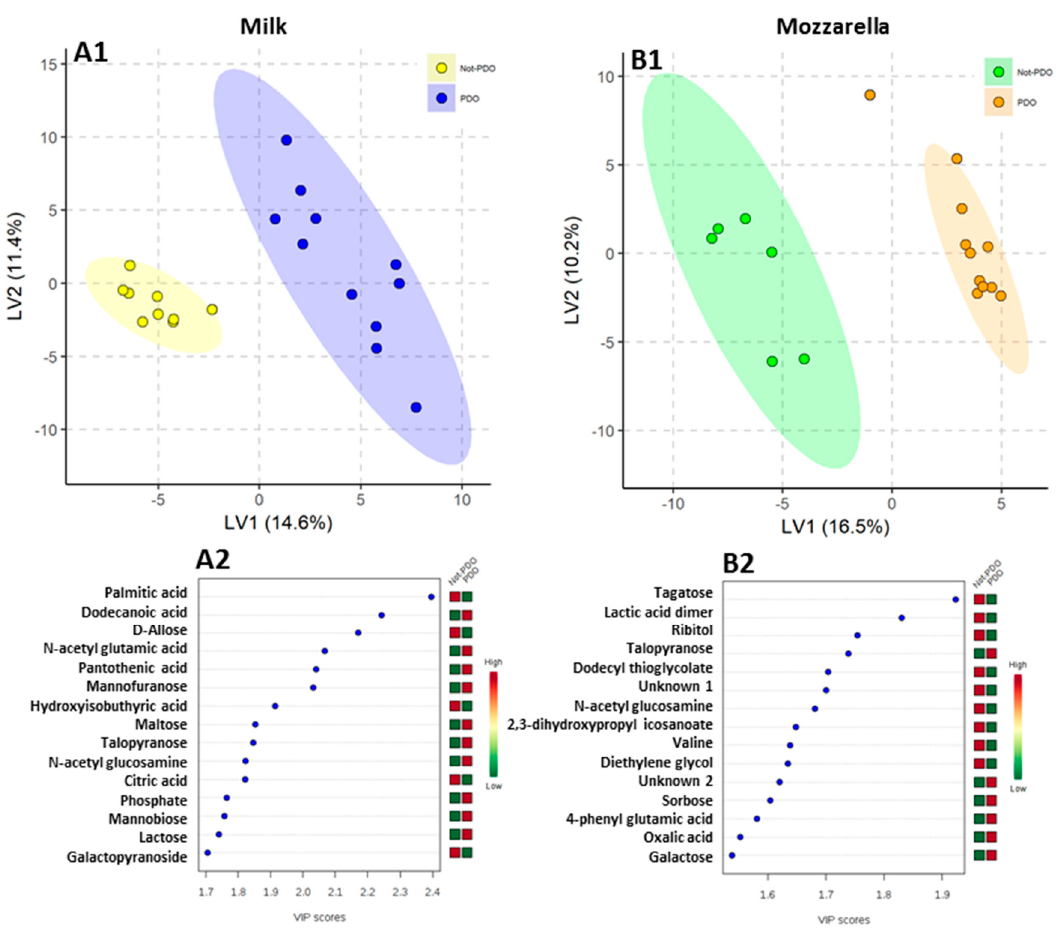
Figure 1. Partial least square discriminant analysis (PLS-DA) models to discriminate PDO and non-PDO buffalo milk ( A1 ) and mozzarella ( B1 ) samples. The explained variance of each component is shown in parentheses on the corresponding axis. ( A2 ) and ( B2 ) panels show the 15 top-scoring variable importance in projection (VIP) metabolites (VIP-score ≥ 1.5) for milk (A2) and mozzarella (B2) samples. The colored boxes on the right indicate the relative amount of the corresponding metabolite in each group under study.